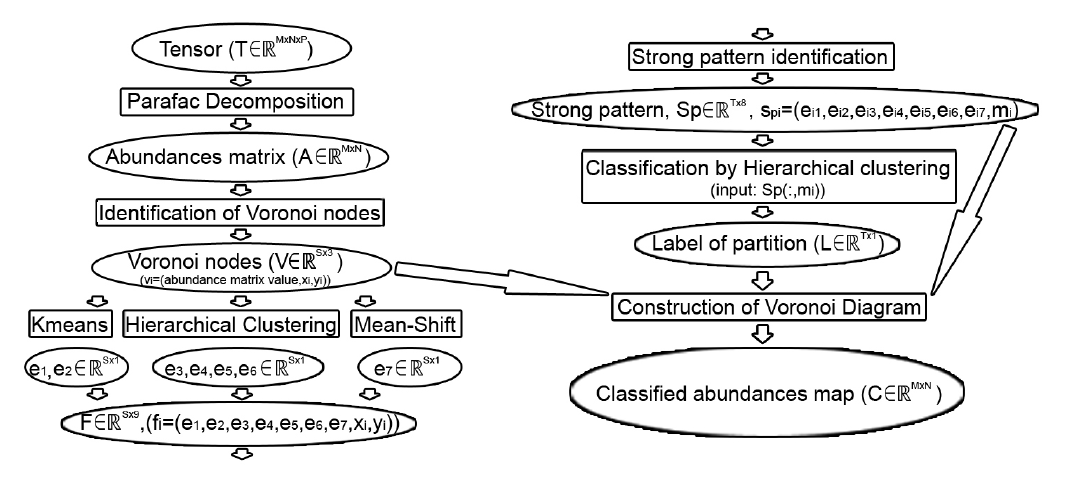
Figure 1. The process flow of the proposed classification method. T ∈ R M × N × P —Hyperspectral image; A ∈ R M × N —the abundances matrix; V ∈ R S × 3 —the Voronoi nodes, where S is the number of nodes; e 1 , e 2 , e 3 , e 4 , e 5 , e 6 , and e 7 ∈ R S × 1 —the label of nodes for each used classification; F ∈ R S × 9 —matrix with partitions and coordinates of nodes; Sp ∈ R T × 8 —the strong pattern, where T is the number of strong patterns, and the last column of Sp contains the mean of abundances matrix values of all pixels corresponding to each strong pattern; L ∈ R T × 1 —the label for each strong pattern after hierarchical classification; C ∈ R M × N —the classified abundances map after we construct the Voronoi diagram using Voronoi